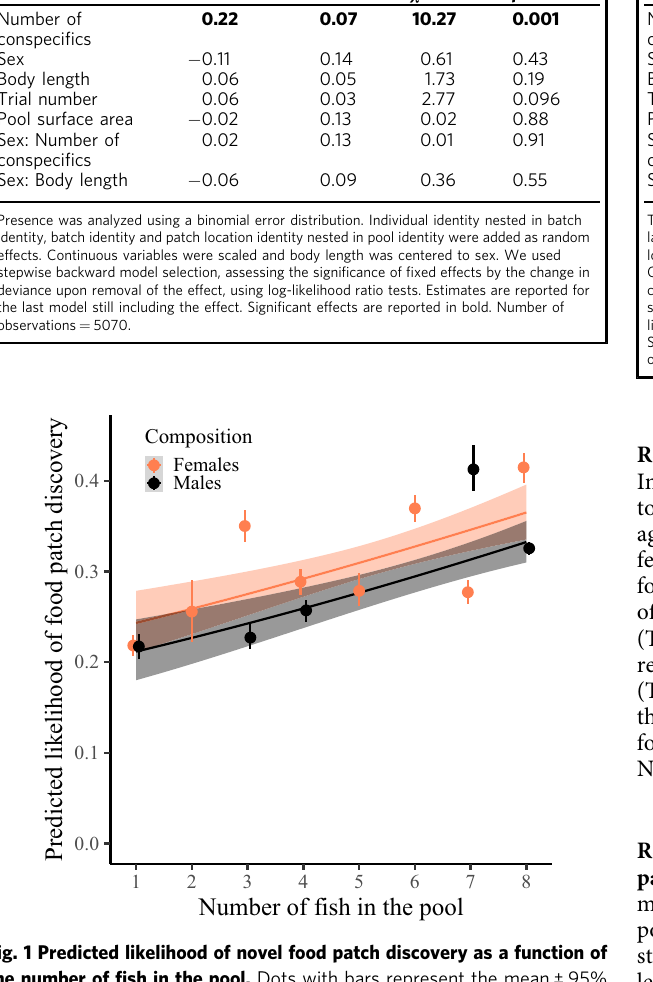
Fig. 1 Predicted likelihood of novel food patch discovery as a function of the number of fi sh in the pool. Dots with bars represent the mean ± 95% con fi dence interval (CI) predicted value summary statistics for each sex (female/male = orange/black) and fi sh number (CI obtained from 1000 bootstraps). Grouping of the data was conducted for graphical purposes only; analyses were conducted on an individual-by-trial level ( n = 5070) with the number of fi sh in the pool as a continuous variable (Table 1). Note that there were no batches with two, fi ve or six males (Supplementary Table 2). Regression lines show the predicted fi nal model values. Shaded areas around the lines re fl ect 95% CI. A slight horizontal position dodge was added to reduce overlap.